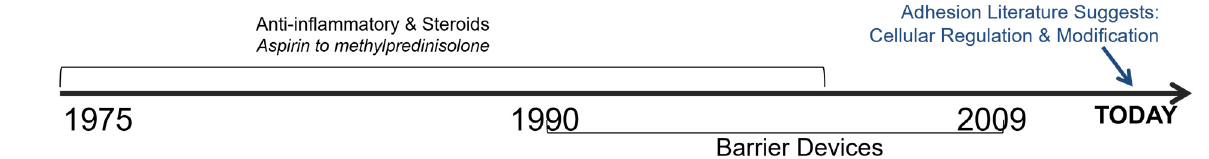
Figure 1. History of adhesion preventing drugs and device development.